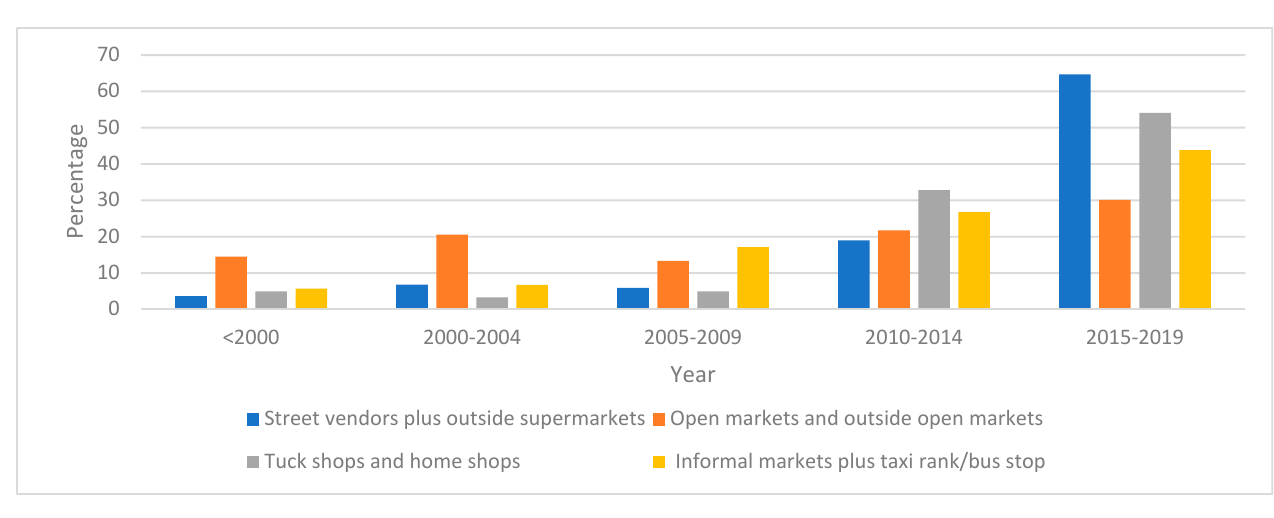
Figure 2. Startup year by type of enterprise. Table 6. EM scores by startup